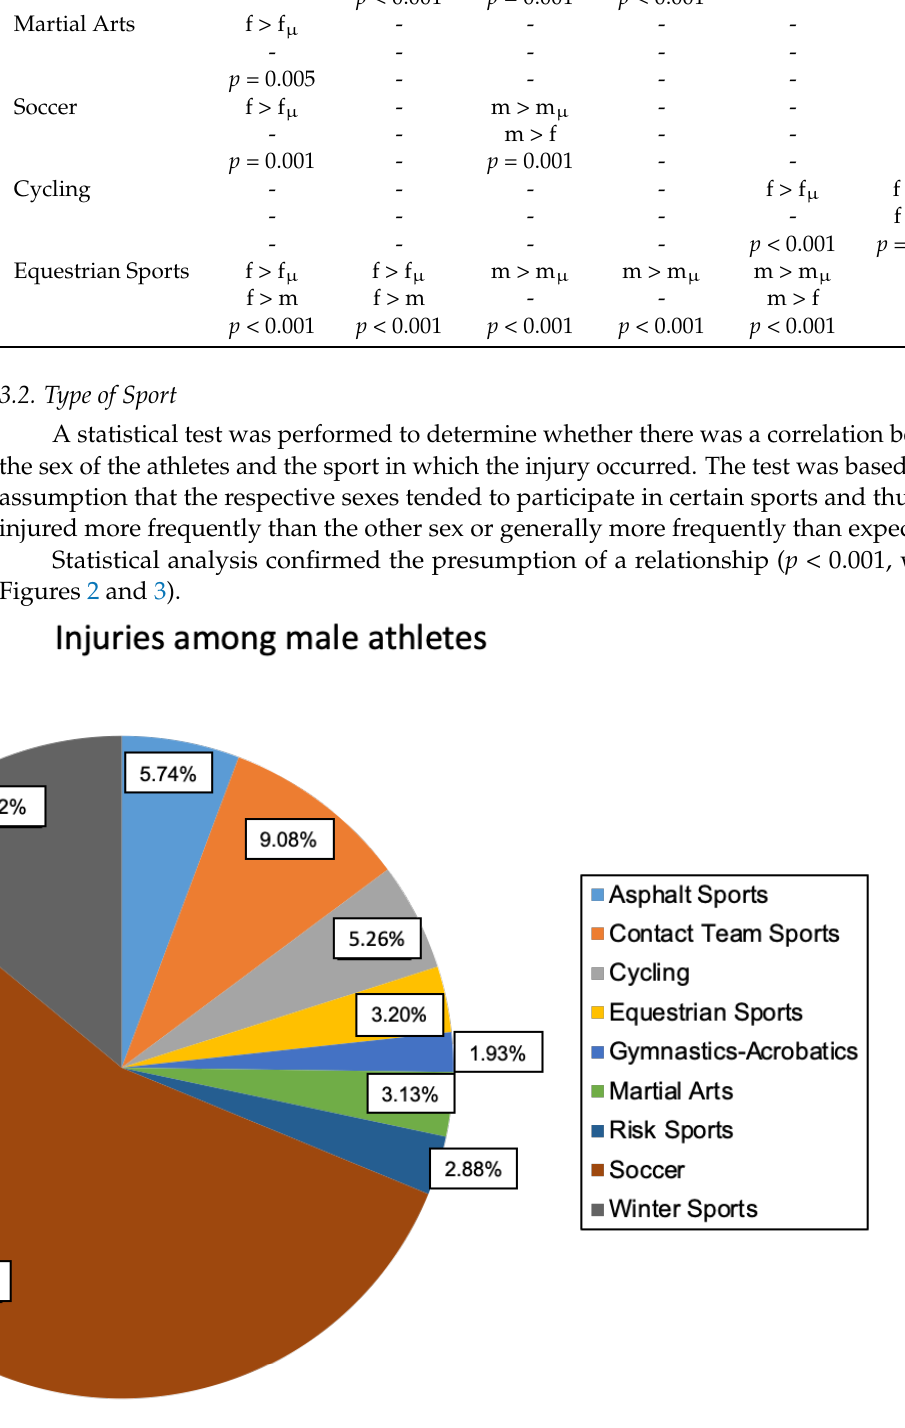
Figure 2. Distribution of injuries among the sports studied (male athletes).